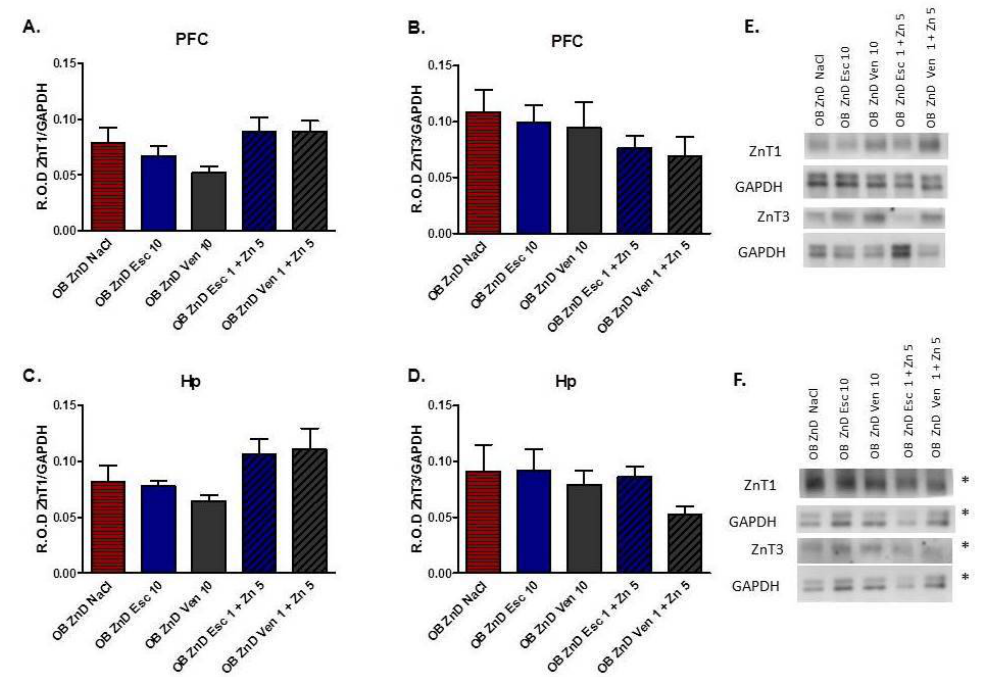
Figure 6. The effects of antidepressants (Esc, Ven) and Zn supplementation on zinc transporter protein levels in the prefrontal cortex (PFC, ( A , B )) and hippocampus (Hp, ( C , D )) of rats subjected to the OB + ZnD model. Representative blots for PFC ( E ); representative blots for Hp [( F ), * the images are from the same membrane]. Data were analyzed using a one-way ANOVA and the Newman–Keuls multiple comparisons test. Values are expressed as mean ± SEM ( n = 6–7).